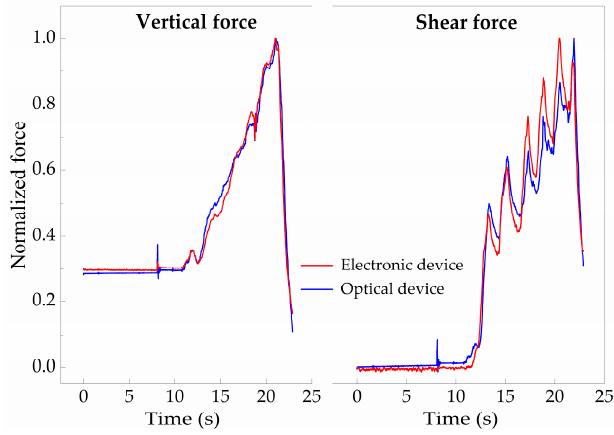
Figure 7. Comparison between the normalized values acquired with the three-axial sensor and the FBGs cell (RMSE V = 0.025 and RMSE S = 0.053).